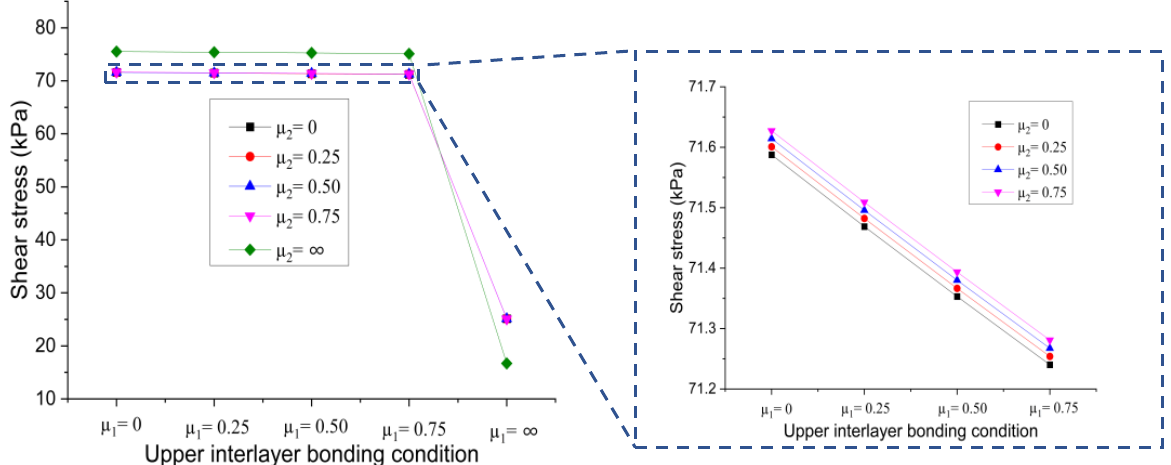
Figure 10. Influence of upper interlayer bonding condition on shear stress at the bottom of upper layer.